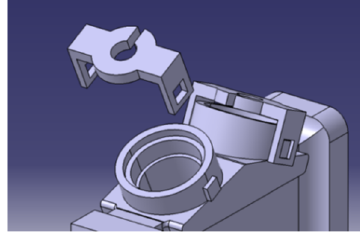
Figure 11. Attachment of the transducers on the pipe.